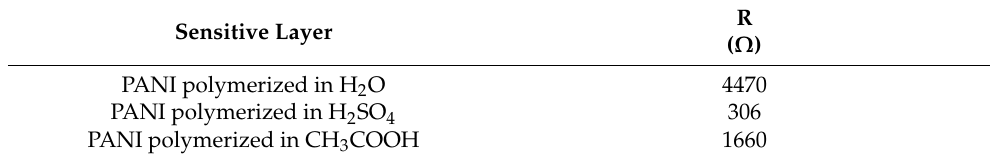
Table 3. Electrical resistance values of sensitive polyaniline layers at 25 ◦ C and 50 % relative humidity.